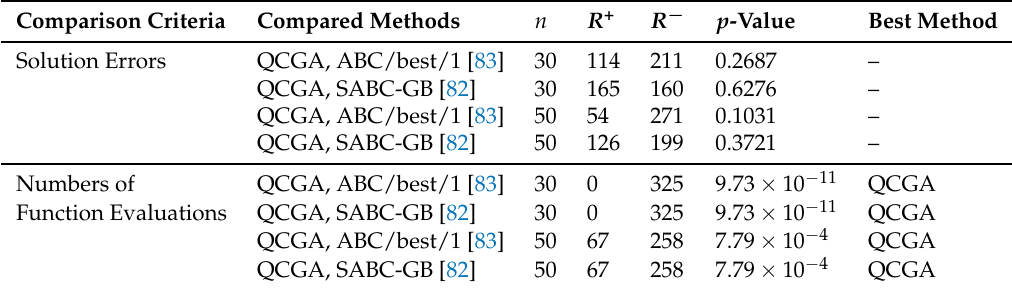
Table 12. Wilcoxon rank-sum test for the hard functions